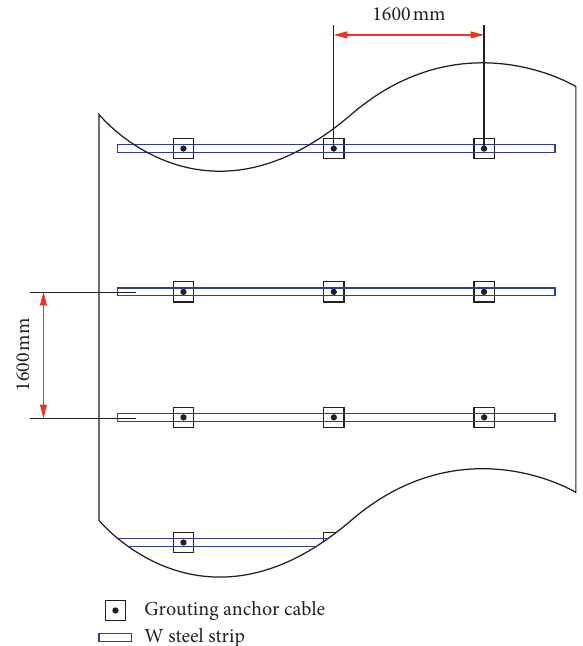
Figure 3: Schematic diagram of advanced support scheme